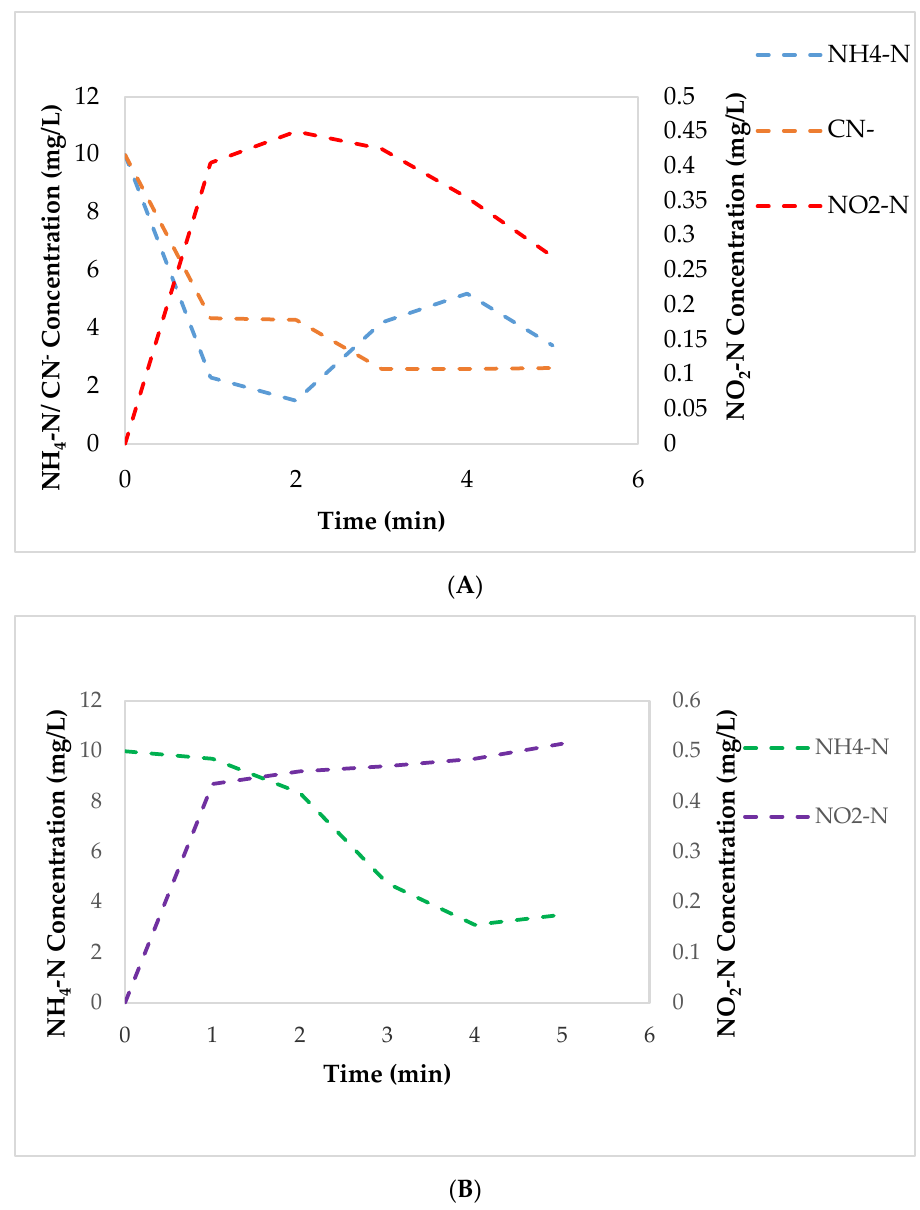
Figure 4. The activity of NH 4 -N, NO 3 -N and NO 2 -N oxidizing enzymes and CN − degrading enzyme. ( A ): Effect of CN − on the induction of NH 4 -N, NO 3 -N and NO 2 -N oxidizing enzymes by A. courvalinii . ( B ): Effect of CN − on free cell NH 4 -N, NO 3 -N and NO 2 -N oxidizing enzymes.